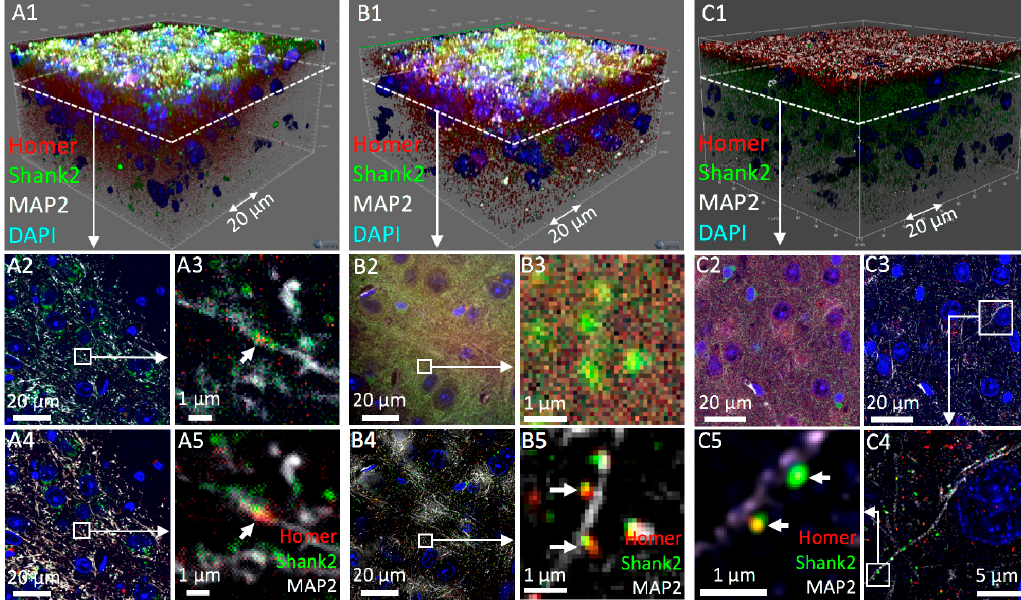
Figure 3. Comparison of various confocal microscopy methods in tissue imaging. Comparison of 3D imaging of a 90 × 90 × 50 (x/y/z) µm 3 region of a mouse brain section immunofluorescently labeled with antibodies against Homer (red), Shank2/ProSAP1 (green) and MAP2 (white) using SIOS (ApoTome) microscopy ( A ), SPDM ( B ) and conventional point-scanning confocal microscopy with deconvolution (HyVolution) ( C ). A1 , B1 , and C1 show 3D reconstructions of deconvolved image stacks. DNA was counter-stained with DAPI (blue). ( A2 ) shows a SIOS-processed single optical section of the image stack recorded in A1 . A subregion of this optical section (white box) is shown in A3 . ( A4 ) and ( A5 ) show the same optical section and subregion, respectively, after deconvolution in ZEN software. Arrows in ( A3 ) and ( A5 ) indicate potential identification of a single synapse at a MAP2-positive dendrite. ( B1 ) The same tissue sample as in ( A1 ) imaged at an adjacent position using a spinning disc confocal microscope. ( B2 ) shows a single confocal section of this image stack. ( B3 ) shows a subregion of the same section. ( B4 ) and ( B5 ) show the same optical section after deconvolution in ZEN software. Arrows indicate identification of Homer/Shank2-positive synapses at dendrites. ( C1 ) The same specimen used in A1 and B1 was subjected to conventional point-scanning confocal microscopy but with the pinhole set to 0.5 Airy units. Furthermore the entire image stack was subjected to deconvolution by Huygens software within Leica’s HyVolution module. ( C2 ) shows a single optical section of the original image stack. ( C3 ) represents the same optical section shown in C2 after deconvolution. A subregion of the deconvolved section was selected for enlarged views ( C4 and C5 ). Arrows in C5 indicate identification of Homer/Shank2-positive synapses at dendrites.